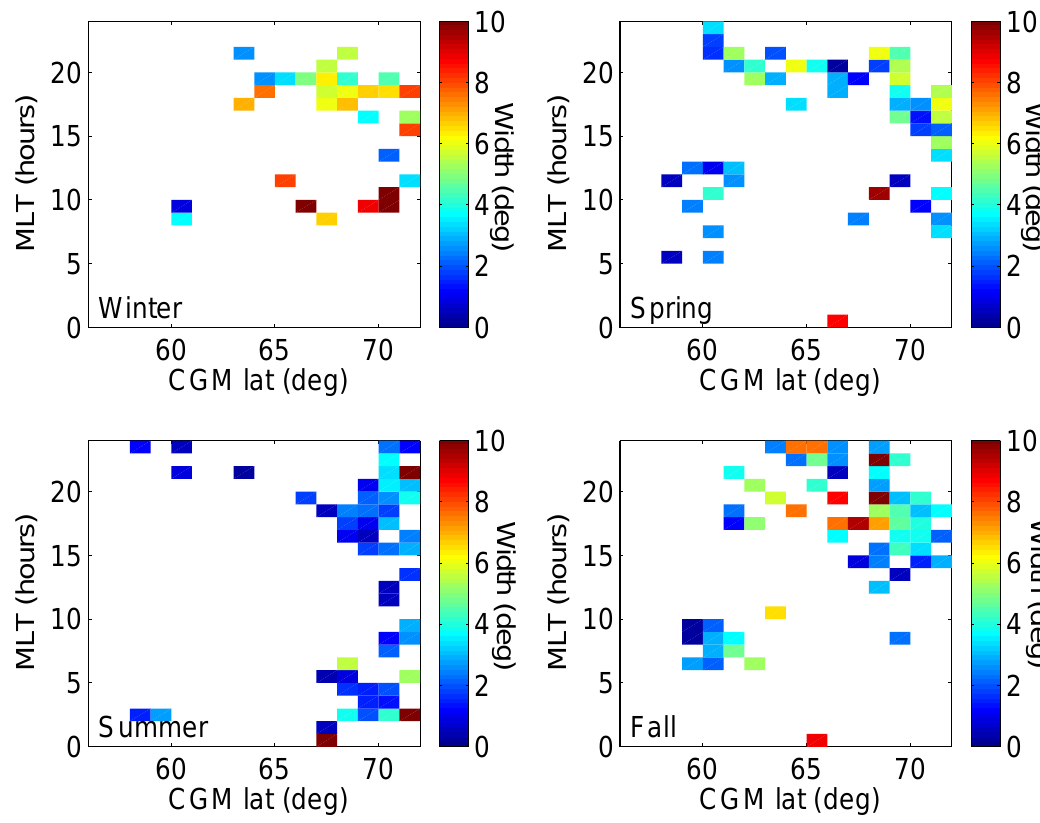
Fig. 4. The mean value of the trough width at different geomagnetic latitudes and magnetic local times of the position of the poleward trough edge.